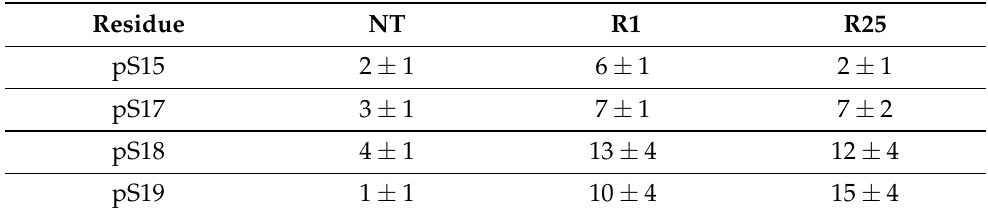
Table 4. Probability of salt bridge formation (%) between phosphorylated residues and positively charged residues in bCPP, where NT is the N-terminus. The data are obtained from Ref. [31].